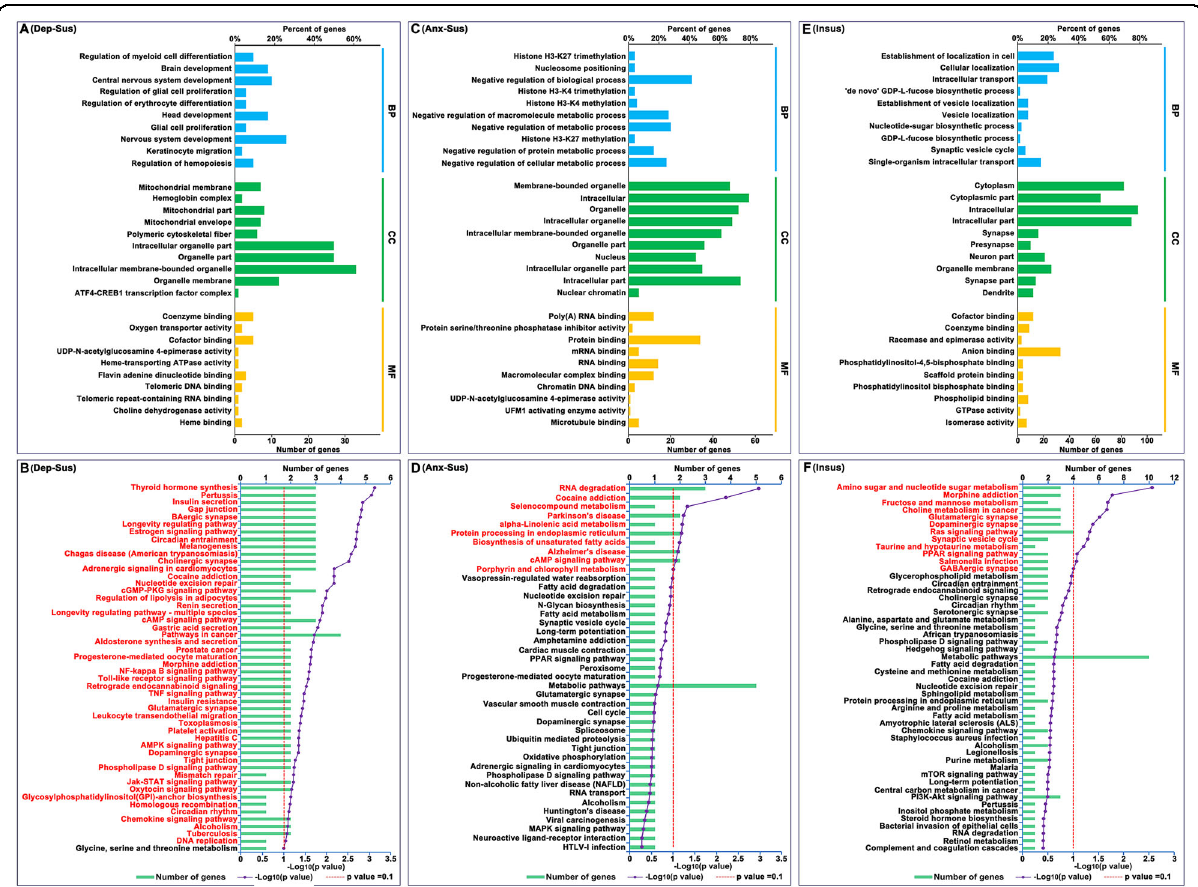
Fig. 3 Enrichment analysis of Gene Ontology and Kyoto Encyclopedia of Genes and Genomes pathway terms. Differentially expressed proteins from the depression-susceptible (Dep-Sus, A ), anxiety-susceptible (Anx-Sus, C ), and insusceptible (Insus, E ) groups were analyzed with Gene Ontology (GO) database, and the top ten enriched biological process (BP), cellular component (CC), and molecular function (MF) terms were shown. The signi fi cantly enriched Kyoto Encyclopedia of Genes and Genomes (KEGG) pathway terms in the Dep-Sus ( B ), Anx-Sus ( D ), and Insus ( F ) groups were indicated with titles in red. The x -axis displays the negative p value